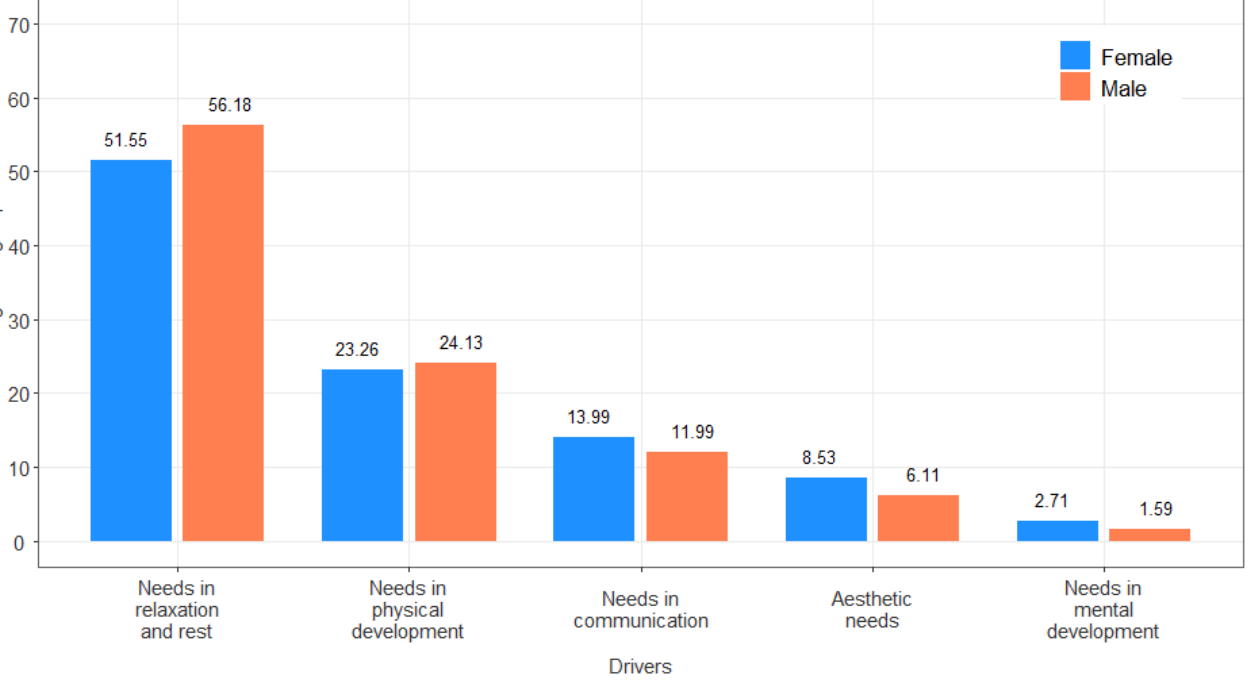
Figure 4. Percentage distribution of the main drivers for forest recreation activities among the respondents from the different gender groups.